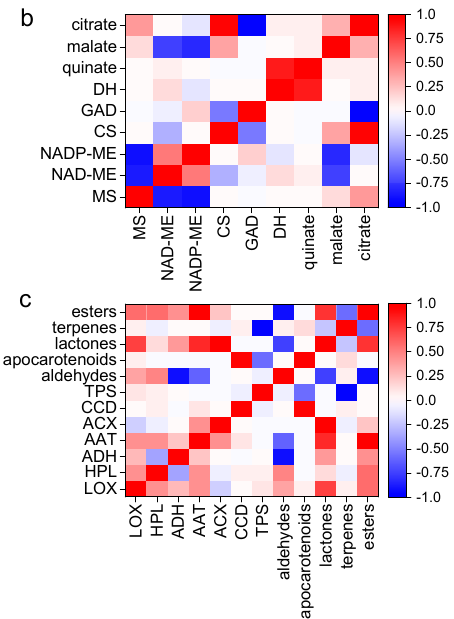
Figure 8. Visualization of Spearman’s correlations between flavor compound contents and metabolism enzyme activities during apricot fruit development. The square color corresponds to the correlation value as shown in the legend: blue represents a negative correlation, and red represents a positive correlation. The white squares correspond to non-significant correlations ( p value > 0.01). ( a ) Correlation between enzyme activities of sugar metabolism and sugar contents: SSthy, sucrose synthase for synthesis direction, SPS, Sucrose phosphatesynthase, SSca sucrose synthase for degradation direction, NI, neutral invertase, AI, acid invertase, SDH, sorbitol dehydrogenase, FK, fructokinase, SO, sorbitol oxidase, GK, Glucokinase; ( b ) Correlation between enzymes activities of